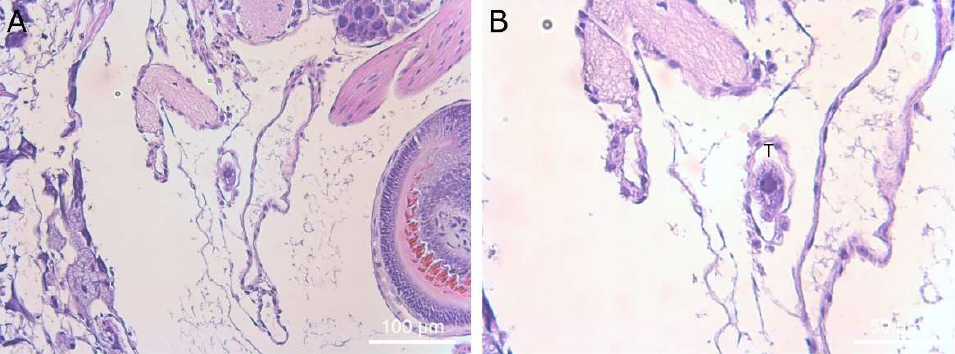
Figure 12. Histological section showing a single ciliate in an artery of the slug. Magnification × 40 ( A ) and × 400 ( B ). Ciliates are marked with a “T” above the cell in panel ( B ).